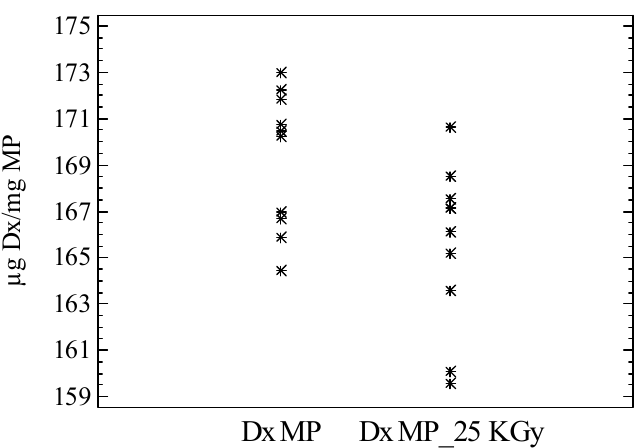
Figure 4. Dexamethasone loading in the microparticles (µg Dx/mg MS) before (Dx MS) and after sterilization (Dx-MS 25 kGy) ( n = 10).